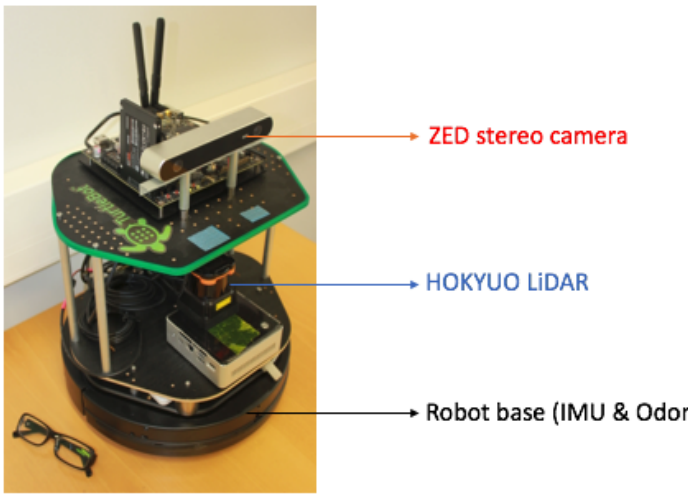
Figure 3. Robotnik TurtleBot 2 equipped with the devices in